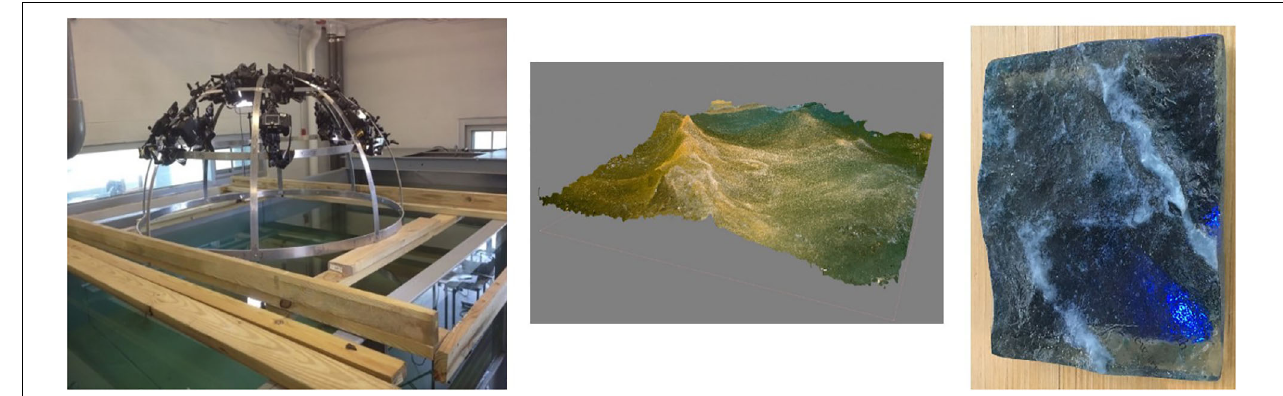
FIGURE 3 | The process of wave capture from technical through digital and physical forms (i) Camera rig designed for photographing the water, (ii) the resulting digital image of captured wave and (iii) a glass wave from above.